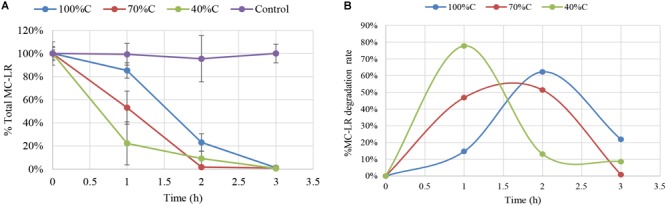
Biodegradation of total microcystin (MC)-LR by Novosphingobium sp. strain THN1 incubated at different carbon concentrations. (A) The remaining MC-LR percentage after 3 h; (B) The biodegradation percentage of MC-LR over 3 h. The initial MC-LR concentration was 1.5 mg L-1.